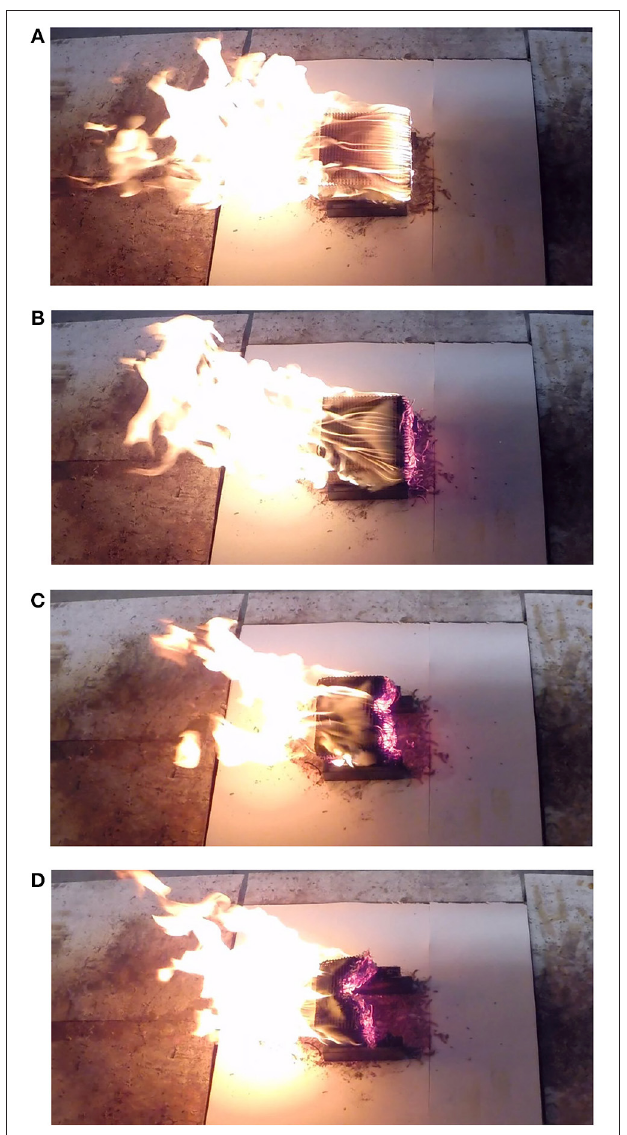
FIGURE 5 | Crib design #22 in 0.7 m/s wind at various times after ignition: (A) approximately 30s, (B) approximately 70s, (C) approximately 195s, (D) approximately 360s.